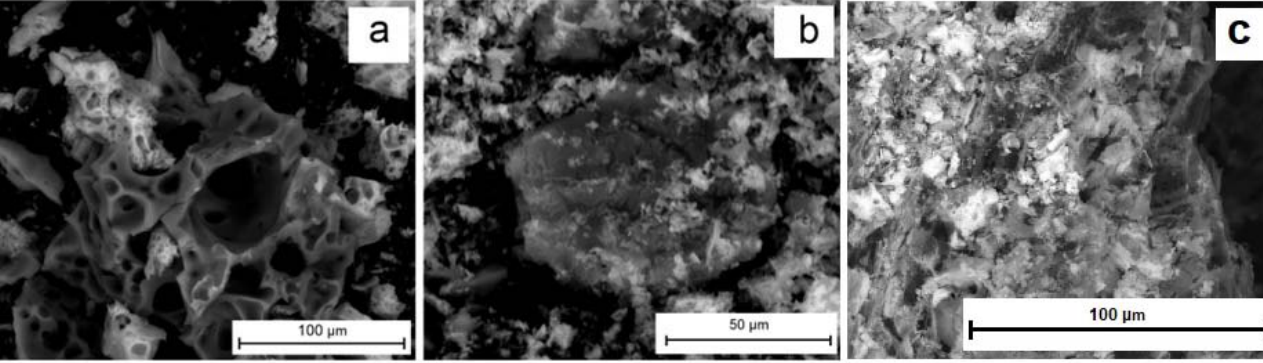
Figure 3. Adsorption–desorption isotherms of N 2 samples: ( a )—CoFe 2 O 4 /S, ( b )—CoFe 2 O 4 /C, ( c )— CoFe 2 O 4. The resulting cobalt (II) ferrite exhibits the properties of a magnetic material. Figure 4 shows the magnetic hysteresis loops of synthesized samples. According to the measure- ments, it demonstrates saturation magnetization of M S = 44 emu/g (electromagnetic unit/g).